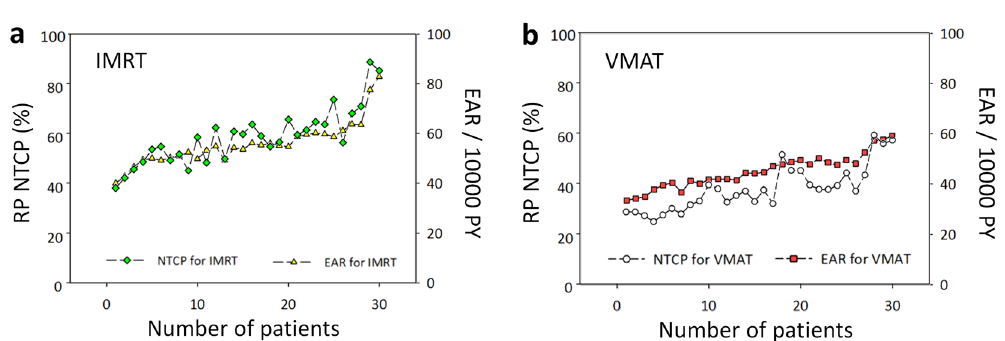
Figure 5. The trends between RP NTCP and EAR of ipsilateral lung for patients treated with ( a ) IMRT or ( b ) VMAT. The EAR has units of excess cases per 10,000 person-years (PY)/Gy. Abbreviations : IMRT, intensity- modulated radiotherapy; VMAT, volumetric-modulated arc therapy; NTCP, normal tissue complication probability; EAR, excess absolute